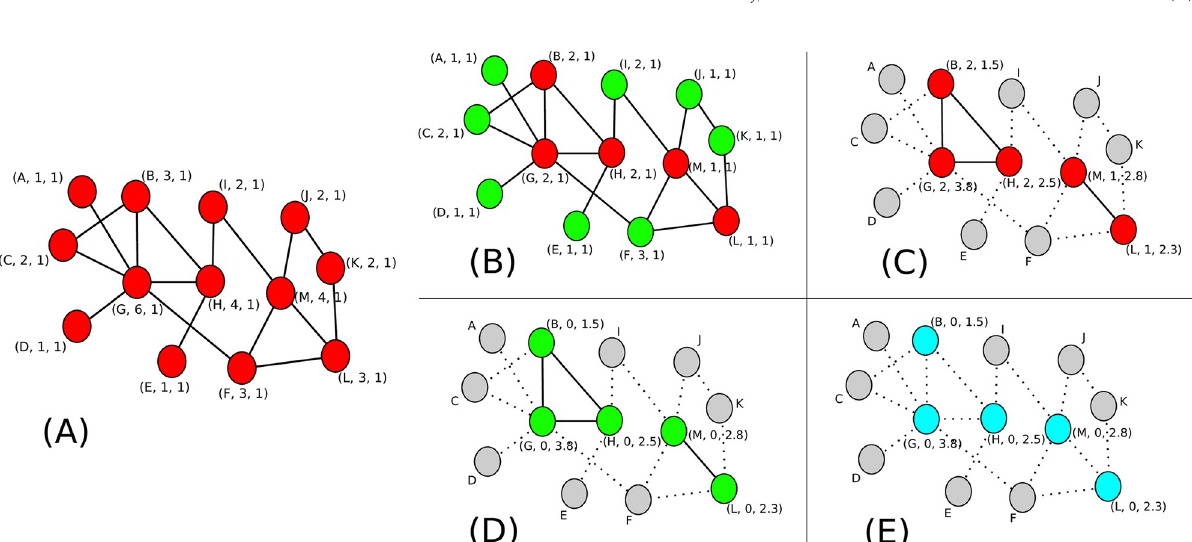
and c are not required in the i i